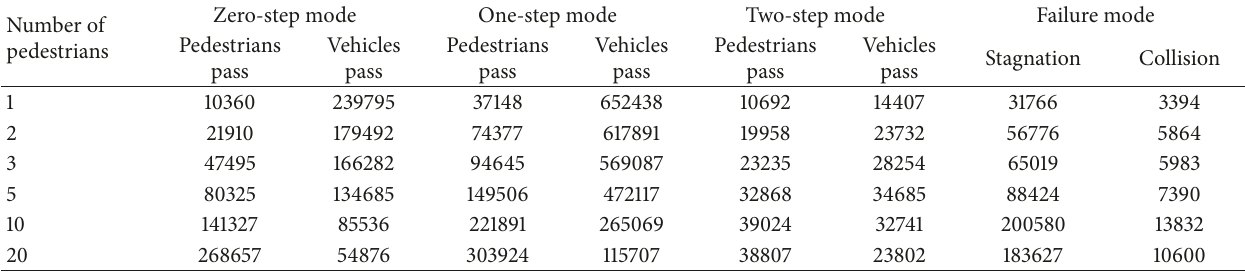
Table 2: Number (out of the sample of 1 million) of pedestrians/vehicles passing through the intersection under different modes ( 𝜇 = 4 s, 𝑢 = 3 s). Number of